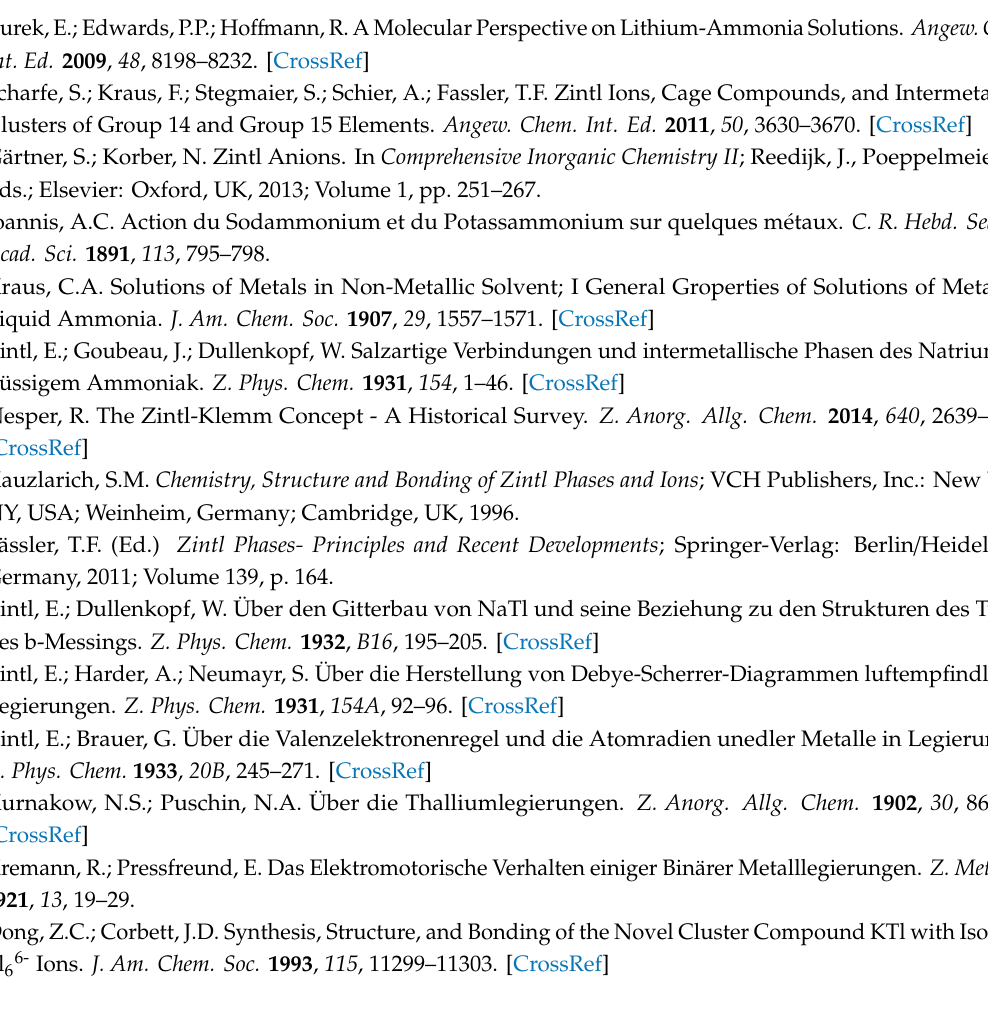
Figure S1: Powder X-ray diffraction pattern of the powder received from the reaction 2 Na + TlI in liquid ammonia. Our observed diffraction pattern is depicted in black in the upper panel of the figure, while the calculated structure of Zintl’s product is shown in the downward facing peaks. Red lines indicate reflections belonging to NaI, while blue lines show the position of the reflections of elemental thallium, Figure S2: Powder X-ray diffraction pattern of washed NaTl. The measured data is shown with positive intensities, whereas the calculated data is depicted with negative intensities. The reflection at 2 Θ = 14.8 ◦ is evidence of traces of elemental thallium still in the